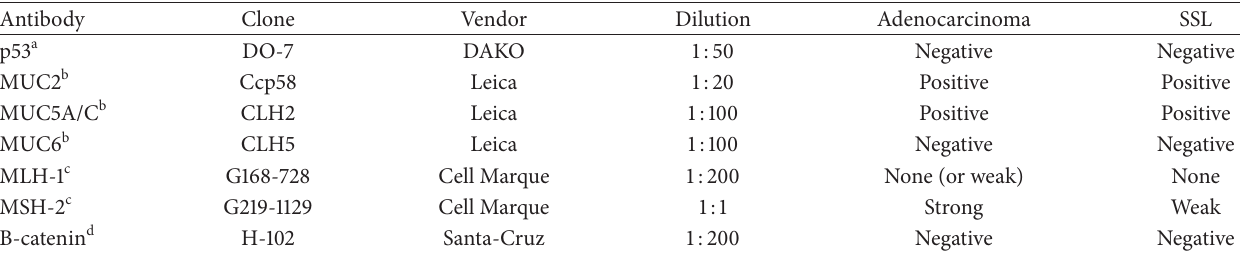
Table 1: Immunohistochemical features comparing adenocarcinoma and SSL.